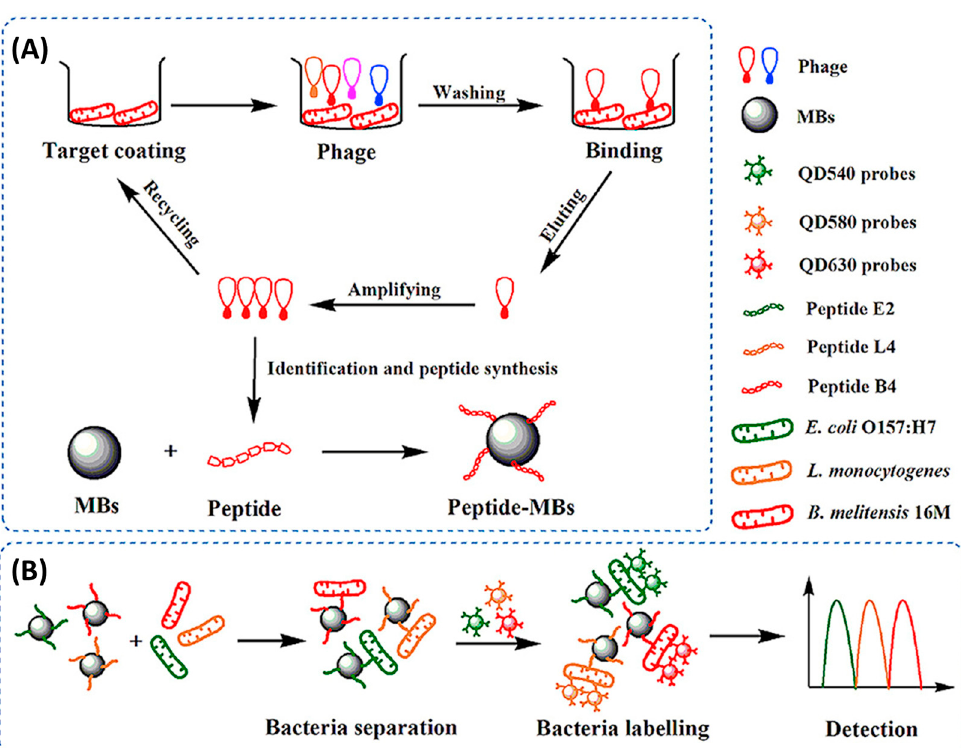
Figure 9. Schematic diagram of the simultaneous detection of E. coli O157:H7, L. monocytogenes and B. melitensis 16M based on phage-displayed peptides and the fluorescence spectroscopy set up [84]. Copyright 2020, Elsevier.